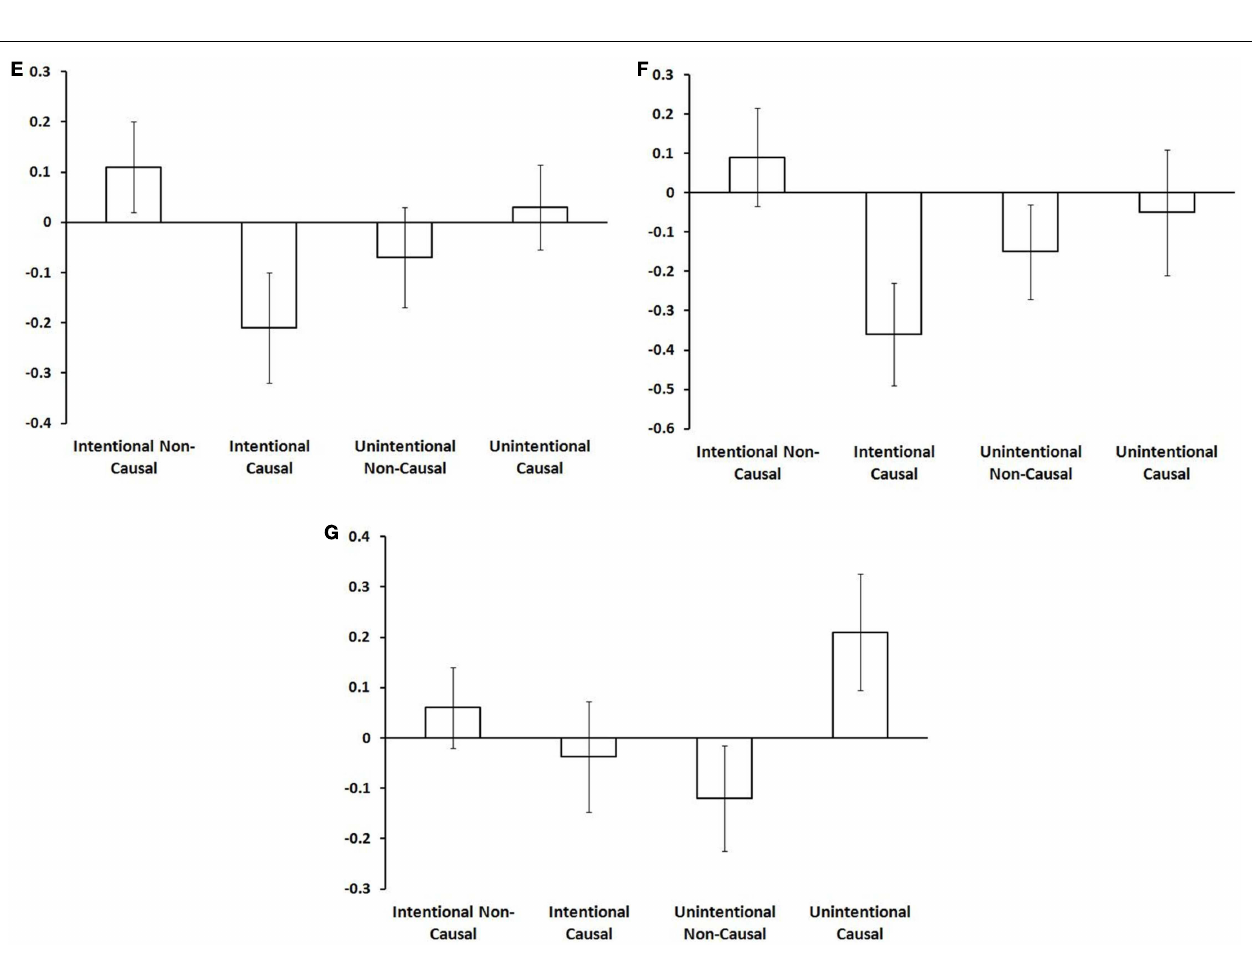
FIGURE 3 | Beta values in each area for each condition (from left to right: intentional non-causal, intentional causal, unintentional non-causal, unintentional causal). Although they are intended for the purposes of guidance only, these plots do suggest differences in the nature of the interaction in these regions.The full cross-over interaction is only found in the